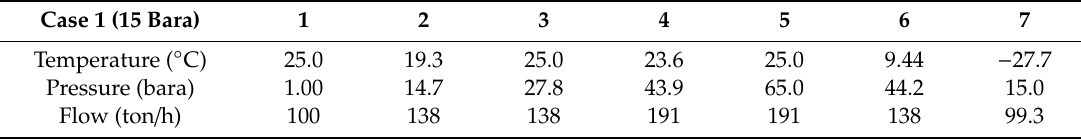
Table A8. Mass balance Case 4, 15 bara liquefaction pressure, stream numbering from Figure 1.